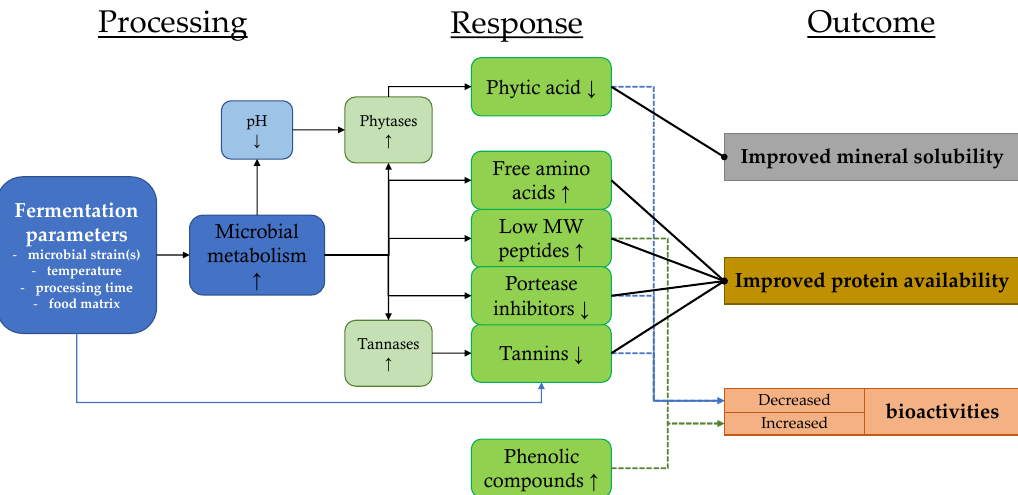
Figure 1. An overview on the e ff ects of the fermentation process parameters and microbial metabolic events on the nutritional quality factors of plant food matrices. Although the overall e ff ect of food fermentation on mineral solubility and protein availability is often positive, and especially protein-derived residues and phenolic compounds may contribute to desirable bioactivities (green dashed lines), the reduction in phytic acid, protease inhibitors, and tannin compounds may lead to a decrease in activities potentially beneficial for human health (blue dashed lines). MW, molecular